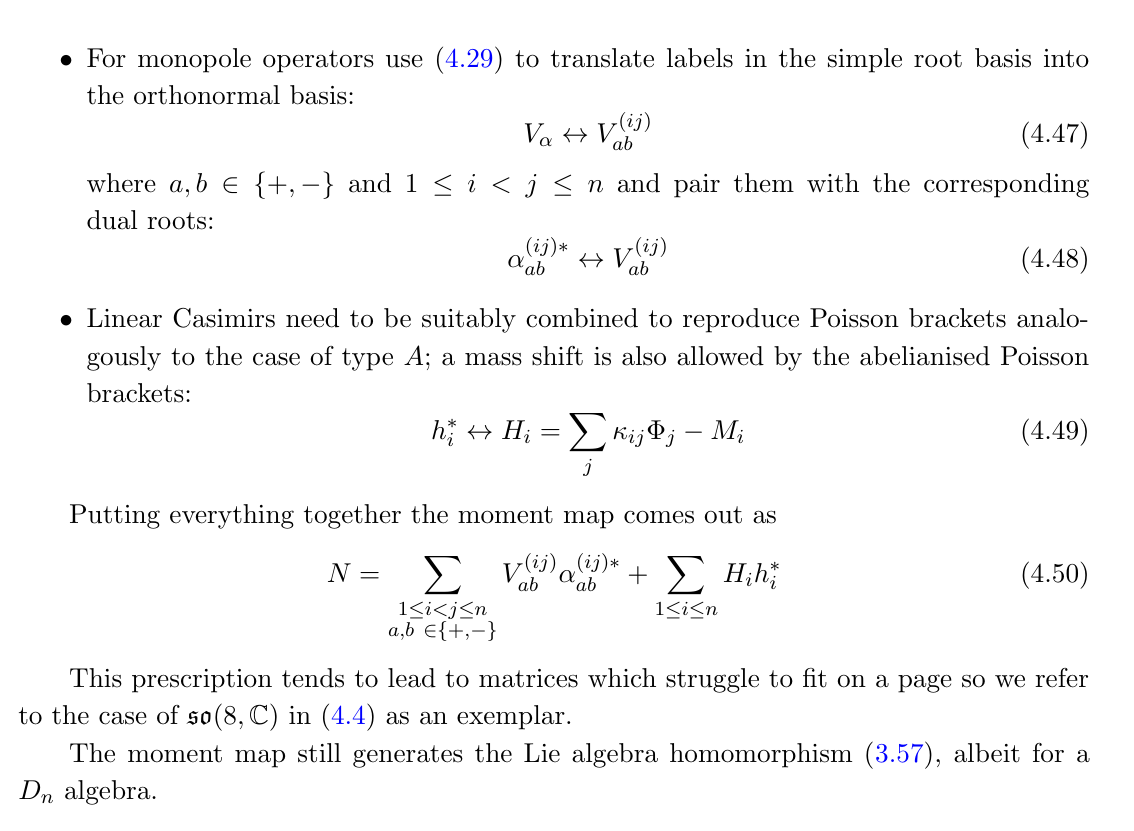
Figure 8 . The Coulomb branch of this quiver is the minimal nilpotent orbit of D n where n is the number of gauge